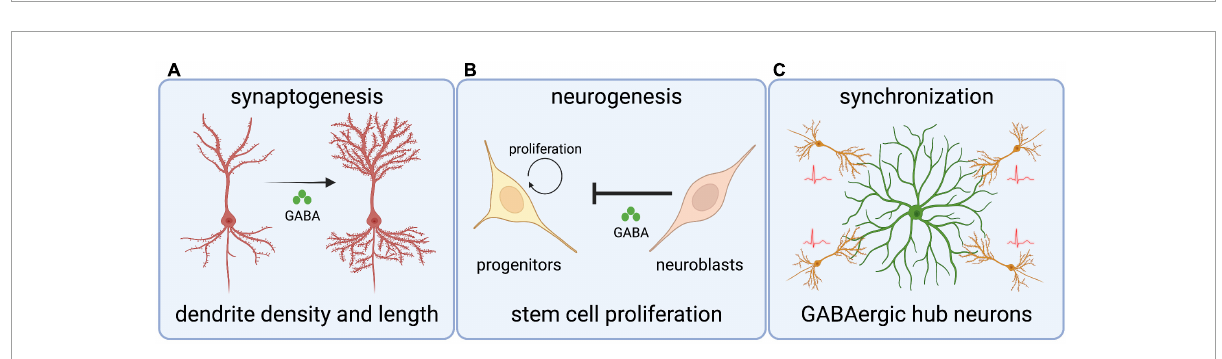
FIGURE2 Roles for chloride transporters and depolarizing GABA in crucial neurodevelopmental processes. (A) Depolarizing GABA (through Cl − transporters) regulates dendritic spine length and density in cortical neurons. (B) GABA signaling from neuroblasts inhibits stem cell proliferation in the subventricular zone. (C) GABAergic hub interneurons synchronize nascent hippocampal networks through giant depolarizing